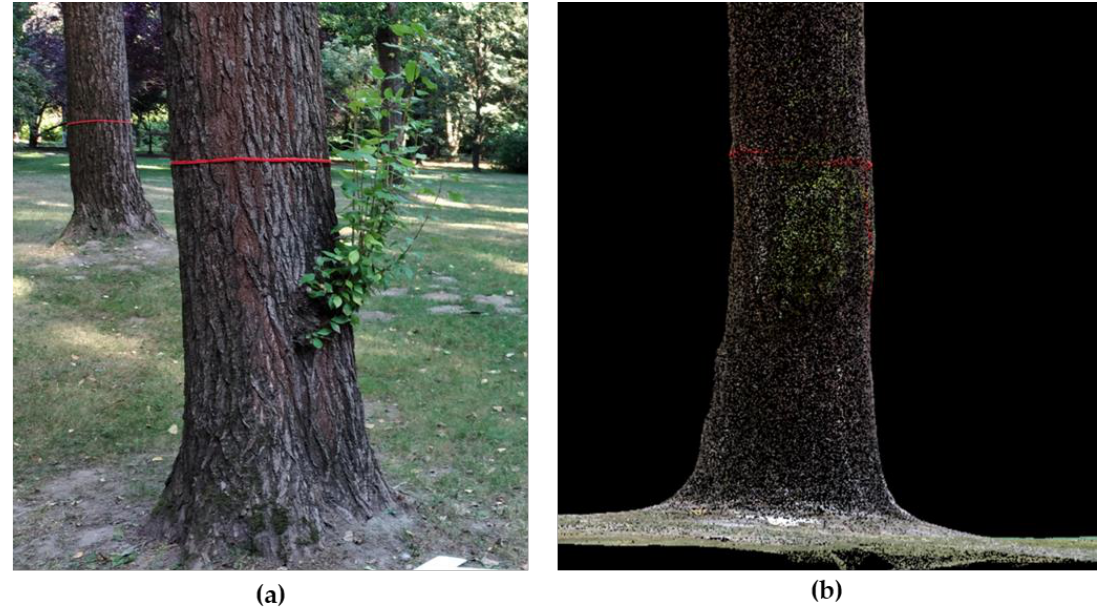
Figure 2. The scanning process of a selected tree of Populus balsamifera : ( a ) the PBH position marked with a red stripe; ( b ) the point clouds of the tree.